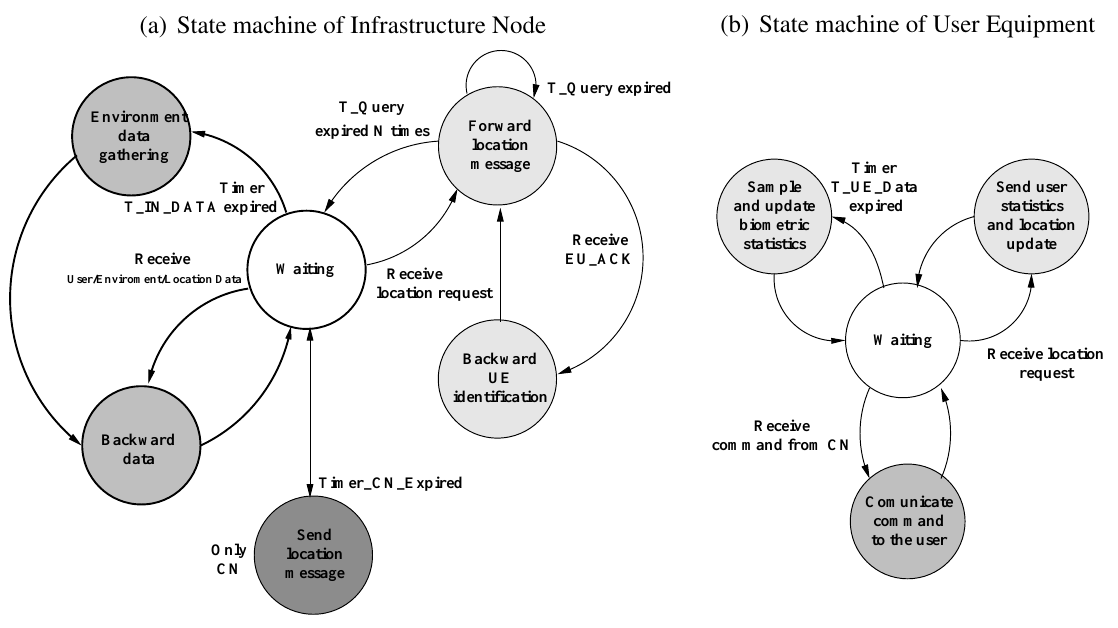
Figure 3. State machine